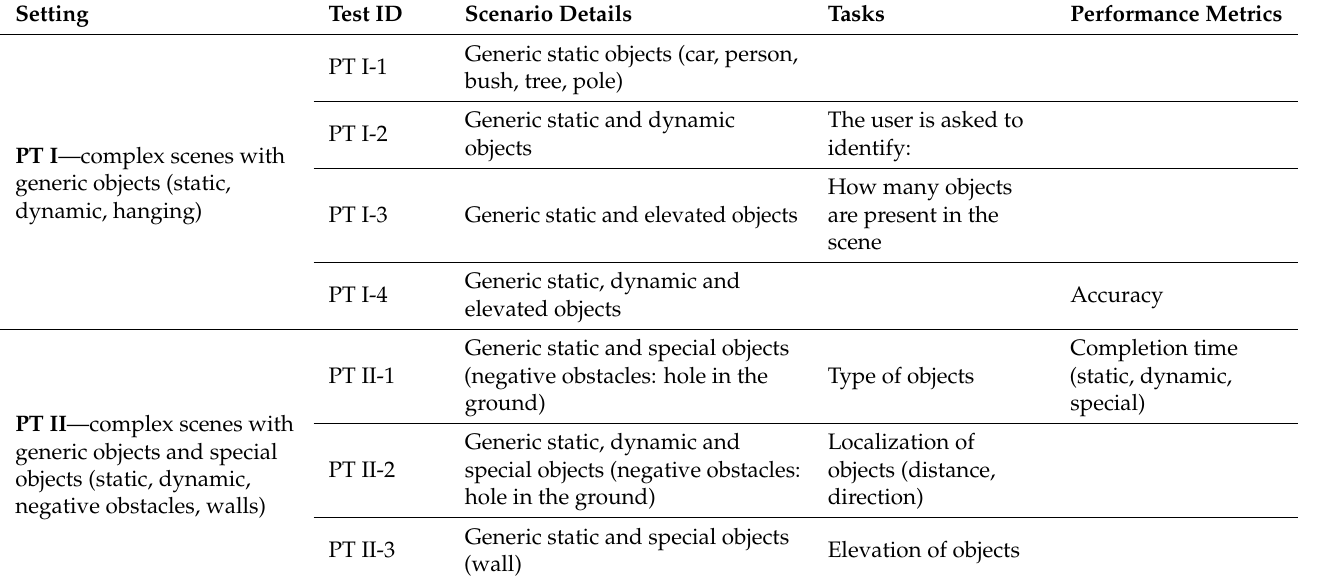
Table 2. Overview of the outdoor tests designed for evaluation of environment perception with the SoV device (PT—perception